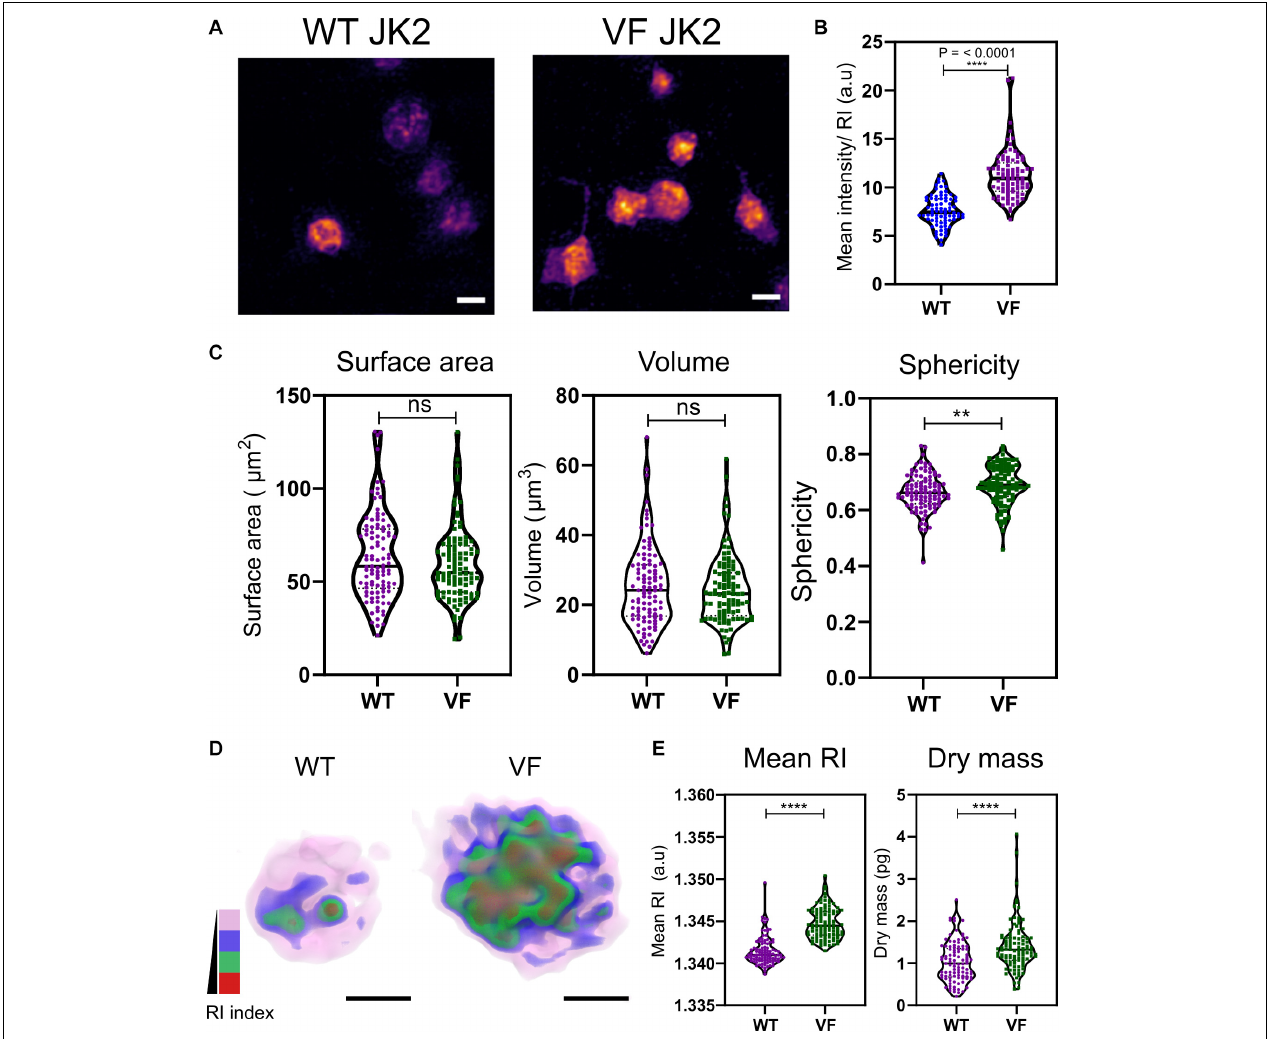
FIGURE 2 | Morphological and biophysical differences in platelets from WT and JAK2V617F+ (VF) from murine blood. (A) Max RI projections of the 3D phase images of platelets from WT and VF mice. (B) The mean intensity values from the RI projections between WT and VF platelets (unpaired two-tailed t -test, P ≤ 0.0001, n = 80 platelets). (C) Morphological changes of platelets from WT and VF mice in surface area platelets (unpaired two-tailed t -test, P = 0.1921), volume (unpaired two-tailed t -test, P = 0.5062), and sphericity (unpaired two-tailed t -test, P = 0.0063 n = 102 platelets, median represented by black line in the violin plot. Scale bar 2 µ m. (D) 3D rendered iso-surface image of platelets from WT and VF mice based on RI. (E) Changes in mean RI (unpaired two-tailed t -test, P ≤ 0.0001) and dry mass (unpaired two-tailed t -test, P ≤ 0.0001) of the platelets. Scale bar 1 µ m, RI scales; Pink: 1.3426–1.3483, blue: 1.3484–1.3519, green: 1.3520–1.3565, red: 1.3566–1.3628. ** P ≤ 0.01, **** P ≤